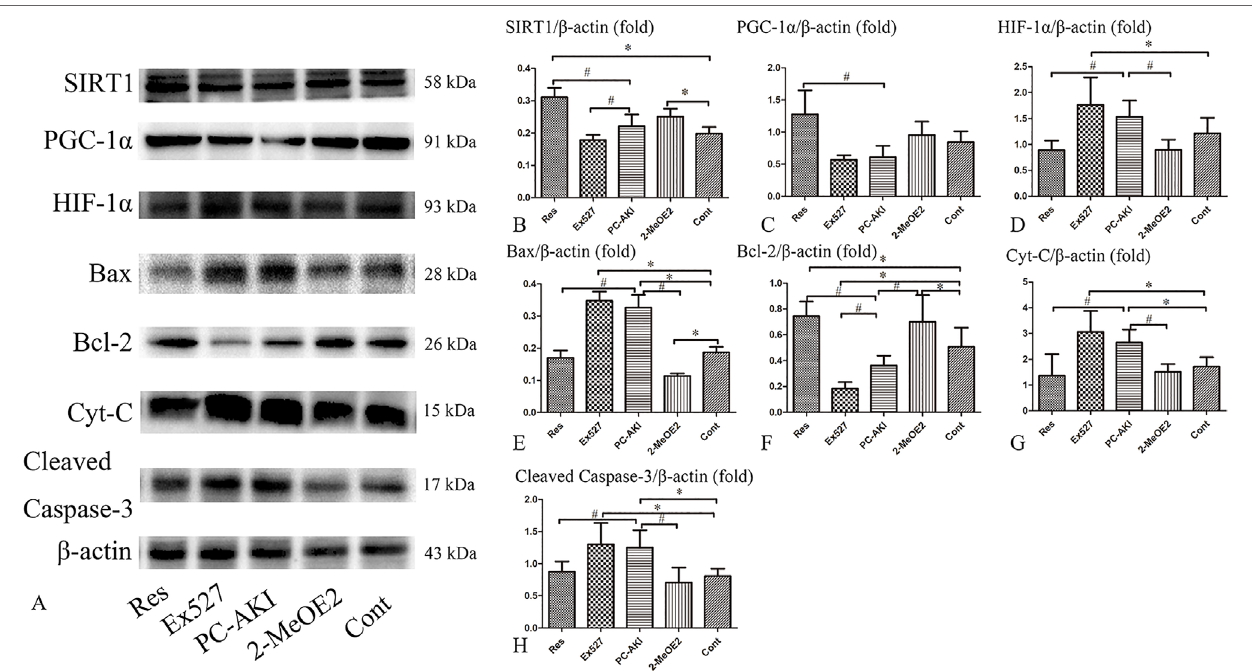
FIGURE 8 | Effects of resveratrol on the expression of SIRT1, PGC-1 α , HIF-1 α and apoptosis proteins in vitro . (A) The expression of SIRT1, PGC-1 α , and Bcl-2 proteins were lower in iohexol treated HK-2 cells compared with control cells, which was reversed by treatment with resveratrol. The expression of HIF-1 α , Bax, cleaved caspase-3, and Cyt-C were markedly increased after iohexol injection, which was reversed by treatment with resveratrol. Furthermore, this effect was enhanced by HIF-1 α inhibitor, 2-MeOE2. (B – H) Relative densitometry of SIRT1–PGC-1 α –HIF-1 α signaling proteins expressed as mean ± standard error. * P < 0.05 vs. Cont; # P < 0.05 vs. PC–AKI. Cont, control; Res, resveratrol; PC–AKI, post-contrast acute kidney injury; SIRT1, silent information regulator l; HIF-1 α , hypoxia- inducible transcription factor-1 α ; Cyt-C, cytochrome C; PGC-1 α , peroxisome proliferator-activated receptor gamma coactivator-1 alpha; Ex527, SIRT1 specific inhibitor; LG, low glucose. Groups: Res, HG+res+iohexol; Ex527, HG+Ex527+iohexol; PC–AKI, HG+iohexol; 2-MeOE2, HG+res+2-MeOE2+iohexol; Cont,